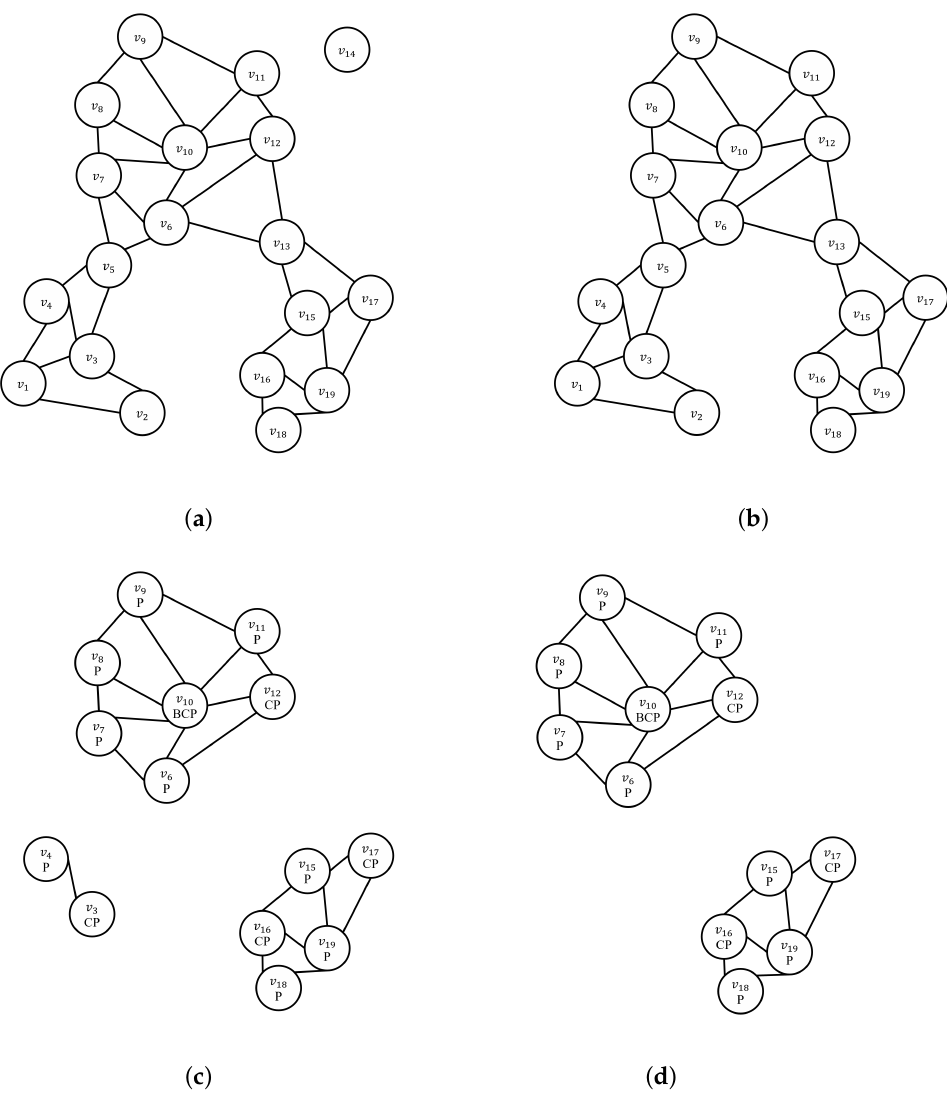
Figure 4. An example of ClusterFirst DBSCAN. ( a ) after constructNNGGraph ( k = 5); ( b ) after density clustering; ( c ) after deepSelection ( dp = ‘person’); ( d ) after re-density